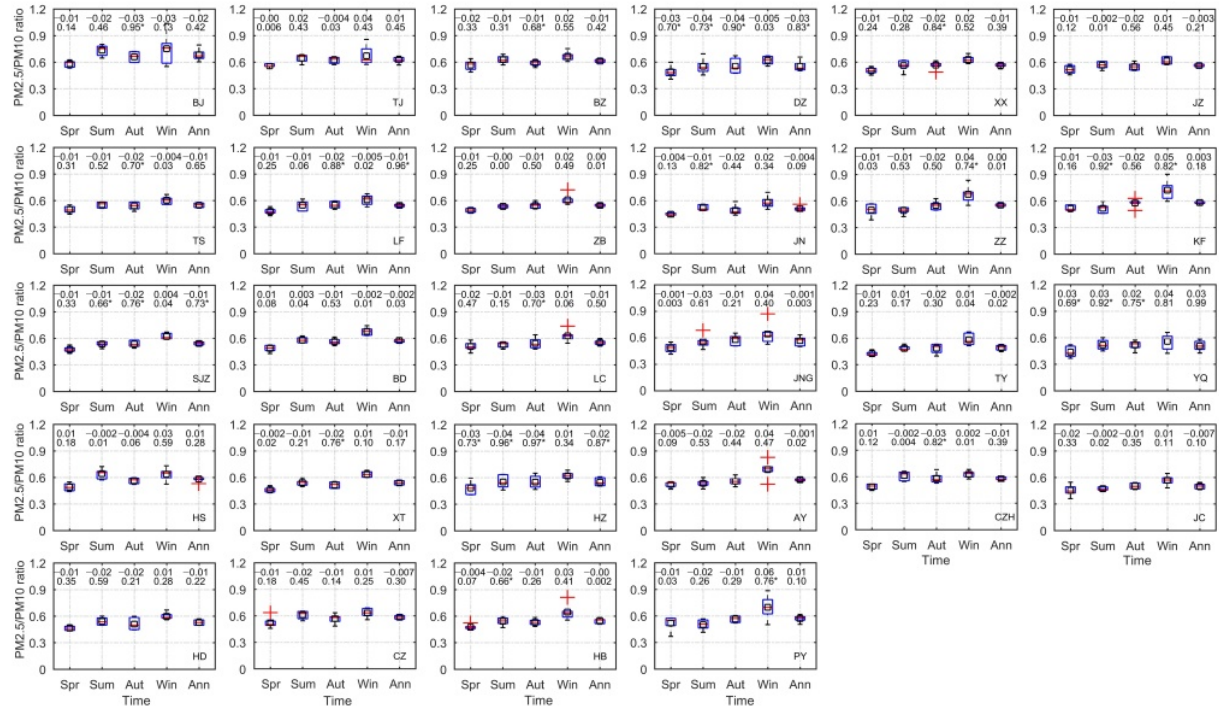
Figure 4. The temporal variation of mean PM 2.5 /PM 10 ratios in the 28 air transport channel cities during 2014–2019. In each box plot, the bottom and top of the box represent the 25th and 75th percentiles, respectively; horizontal red lines indicate median values; open black squares indicate mean values; whiskers show 1.5 times the interquartile range; and red crosses represent outliers. Linear regression slopes and R 2 values are provided for each city (* p < 0.05): BJ, Beijing; TJ, Tianjin;